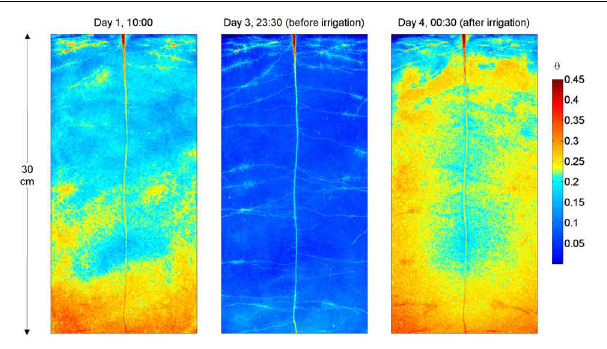
FIGURE 3 | Neutron radiography of L4, during the drying period and after irrigation. The colormap is proportional to the water content. Note the higher water content near the upper roots at day 1. After irrigation (day 4), the rhizosphere of the upper roots, of the tap root, and that of the proximal parts of the lower roots remained markedly drier. On the other hand, the rhizosphere of the root tips in the lower parts of the sample rewetted and a region with high water content is visible around the root